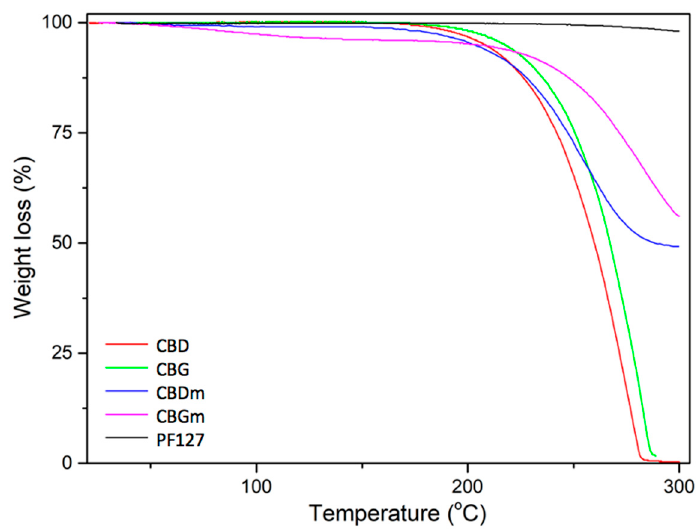
Figure 8. TGA thermograms of CBD, CBG, CBDm, CBGm, and